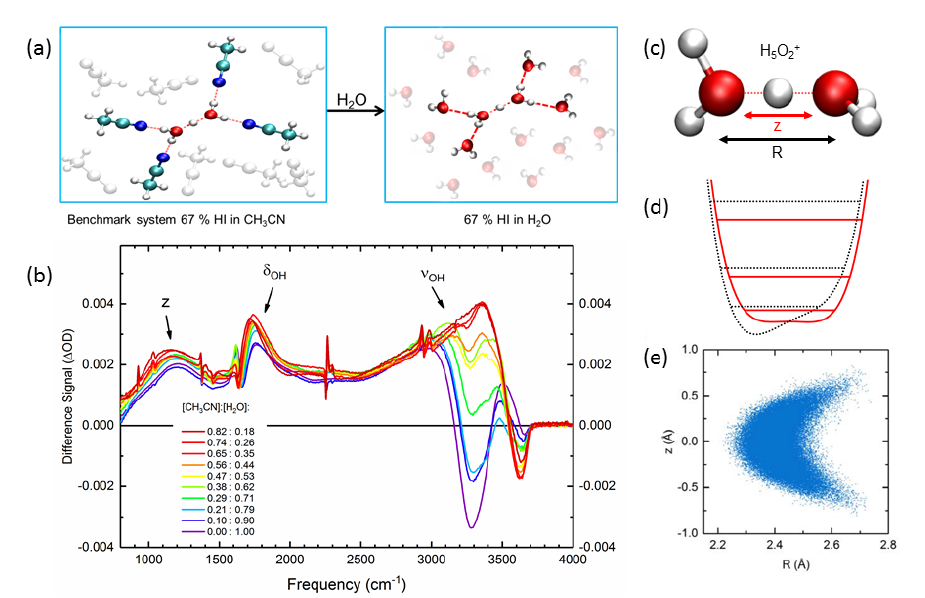
Fig. 1. (a) Hydrogen bonding partners of H 5 O 2+ successively changed from CH 3 CN to H 2 O. (b) ATR- IR spectra of 1 M HI in CH 3 CN:H 2 O mixtures, displaying the IR-active transitions of the ν OH , δ OH and z vibrational modes. (c) The proton transfer coordinate z and O .. O distance coordinate R of H 5 O 2+ . (d) z has a low-barrier double well potential. (e) H 5 O 2+ has a proton distribution function in solution peaking in the centre of the z